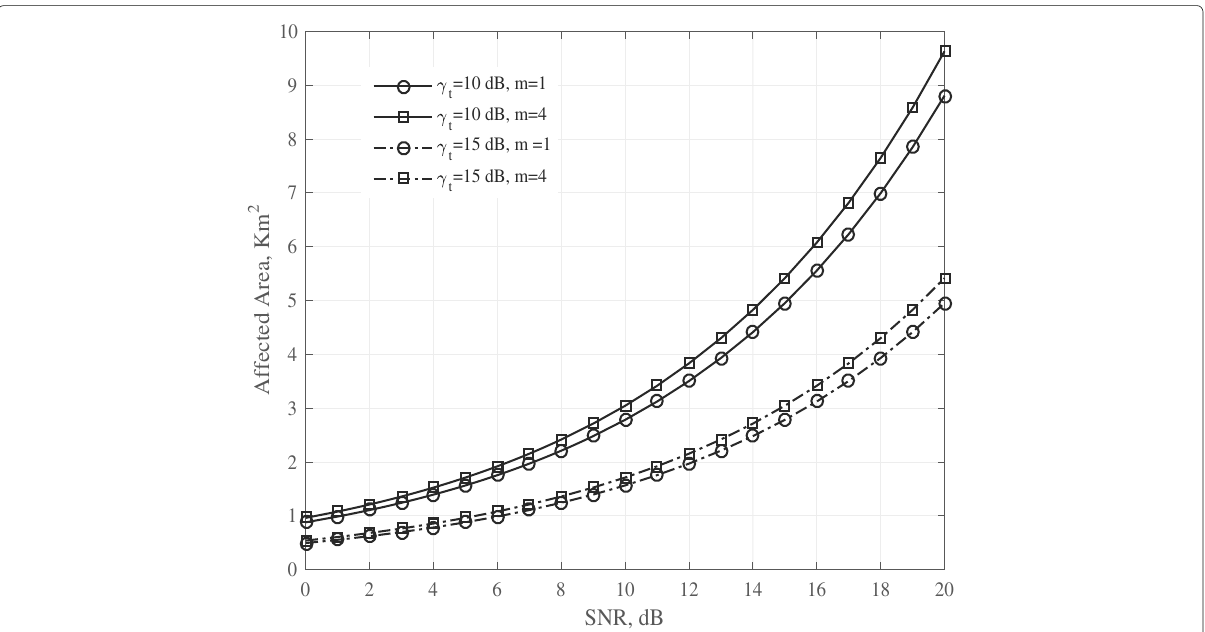
Fig. 8 Affected area as a function of SNR for fading figure, m = 1 and 4, SNR threshold γ t = 10 and 15 dB, and path loss exponent α = 4. Affected area for, m = 1 and 4, and γ t = 10 and 15 dB